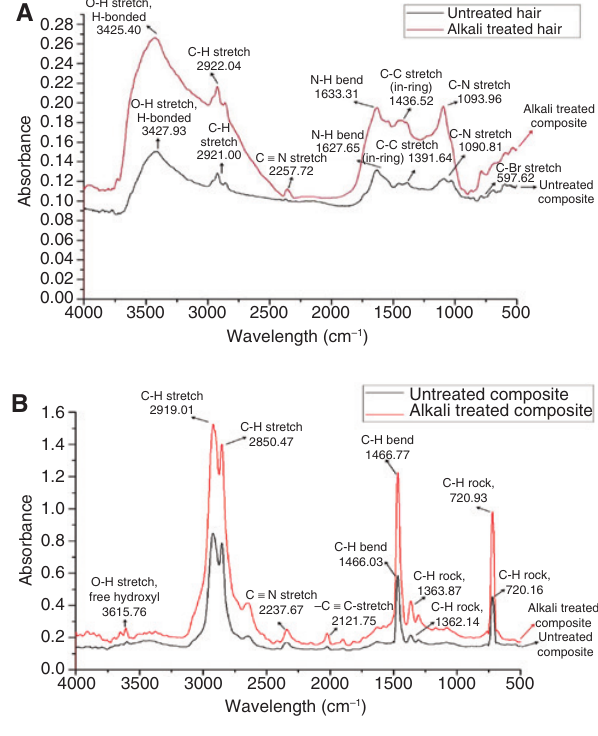
Figure 2: (A) FTIR spectra of the untreated and alkali-treated HFs and (B) FTIR spectra of the untreated and alkali-treated composites.